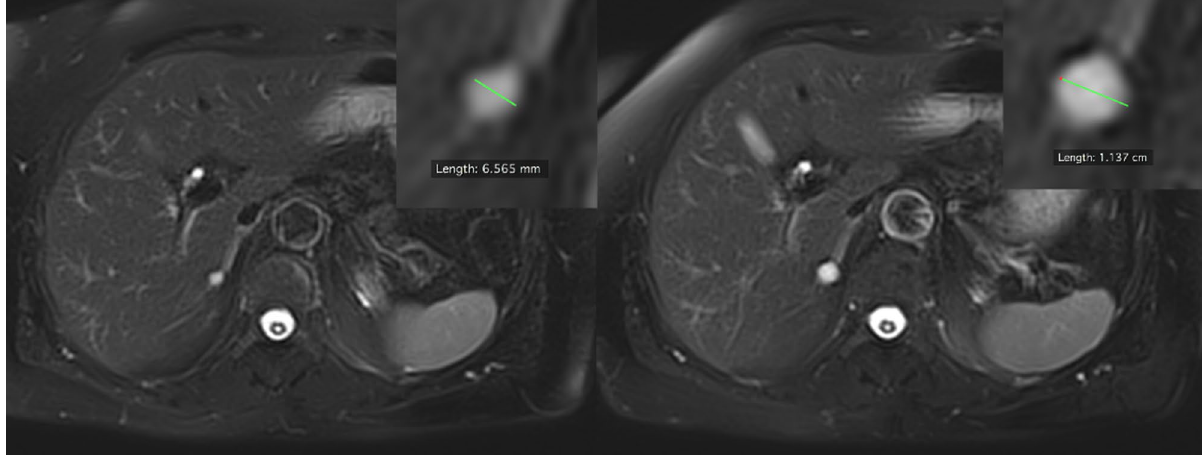
Figure 1. Case with a cyst at baseline and follow-up in segment 6 of the liver on axial T2-weighted TSE sequence. The enlarged segments in the right upper corner of both images depict an example of a cyst measurement. Its size changed from 6.6 mm to 11.4